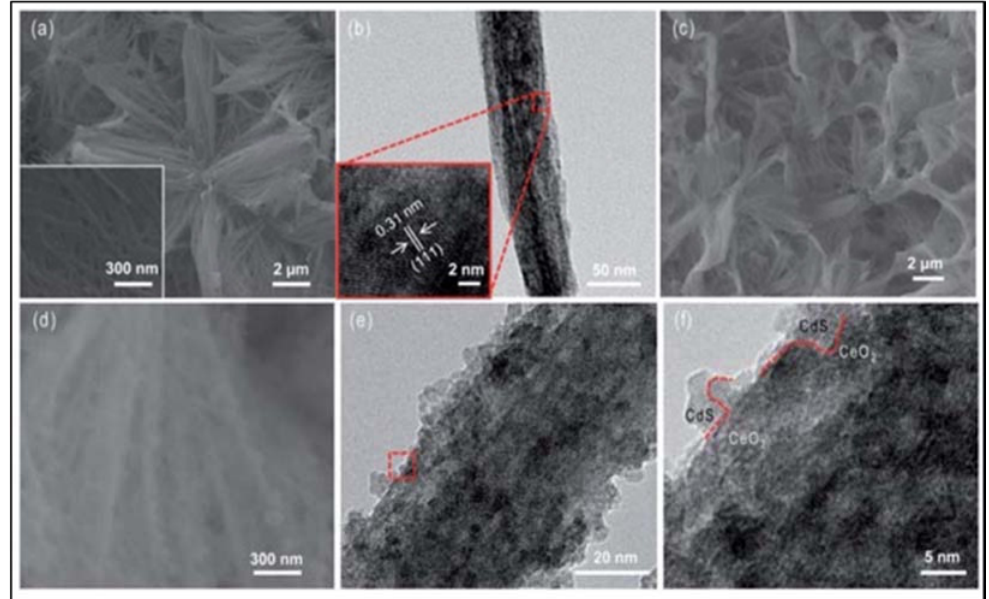
Figure 12. SEM ( a ) and TEM ( b ) images of the CeOx nanowires. The SEM and TEM images of the CdS/CeOx nanowires are presented in ( c – f ). The inset in ( b ) corresponds to ( a ) HRTEM image and SAED spectrum of the CeOx nanowires. Reproduced with permission from reference [128].